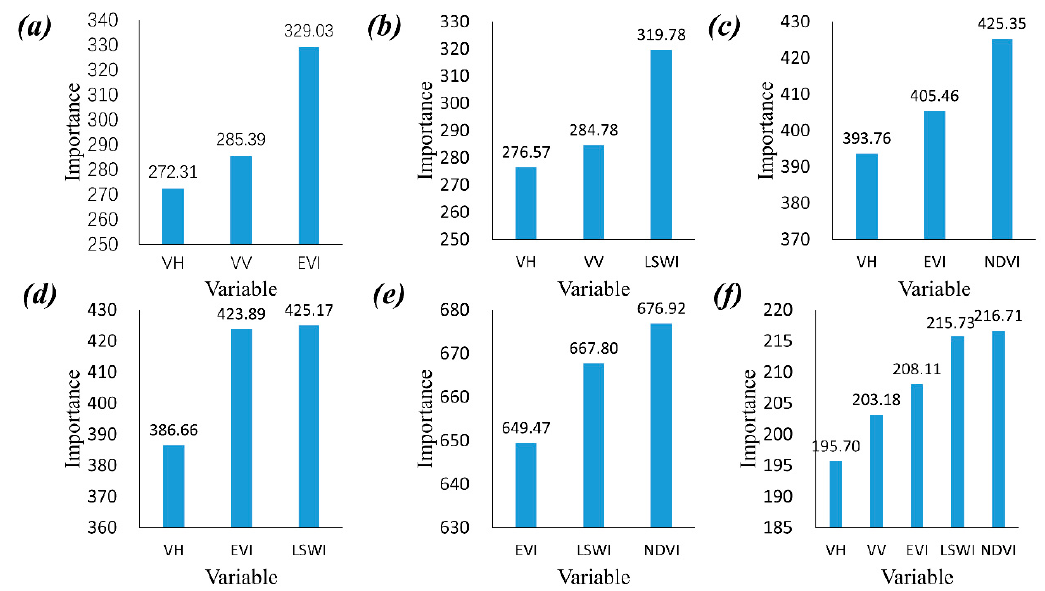
Figure 7. The variable importance ( a ). A6 (VV + VH + EVI). ( b ). A7 (VV + VH + LSWI). ( c ). C3 (VH +